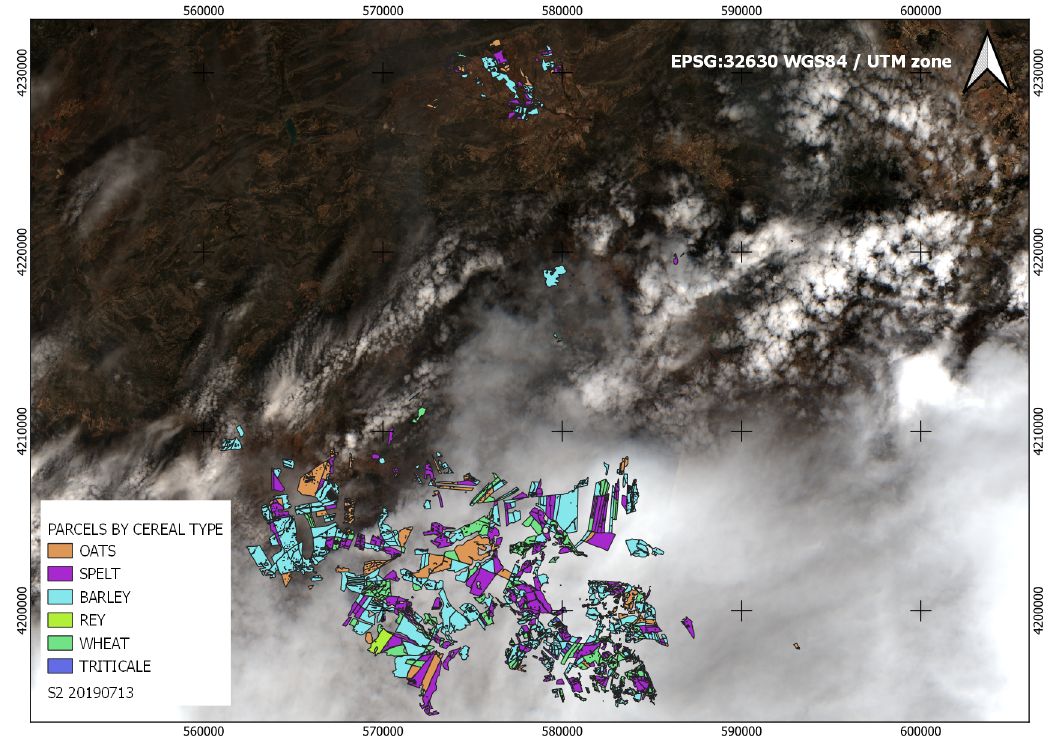
Figure 8. Example of the cloud cover with the pilot areas on 13 July 2019, the first image after the deadline (15 July).